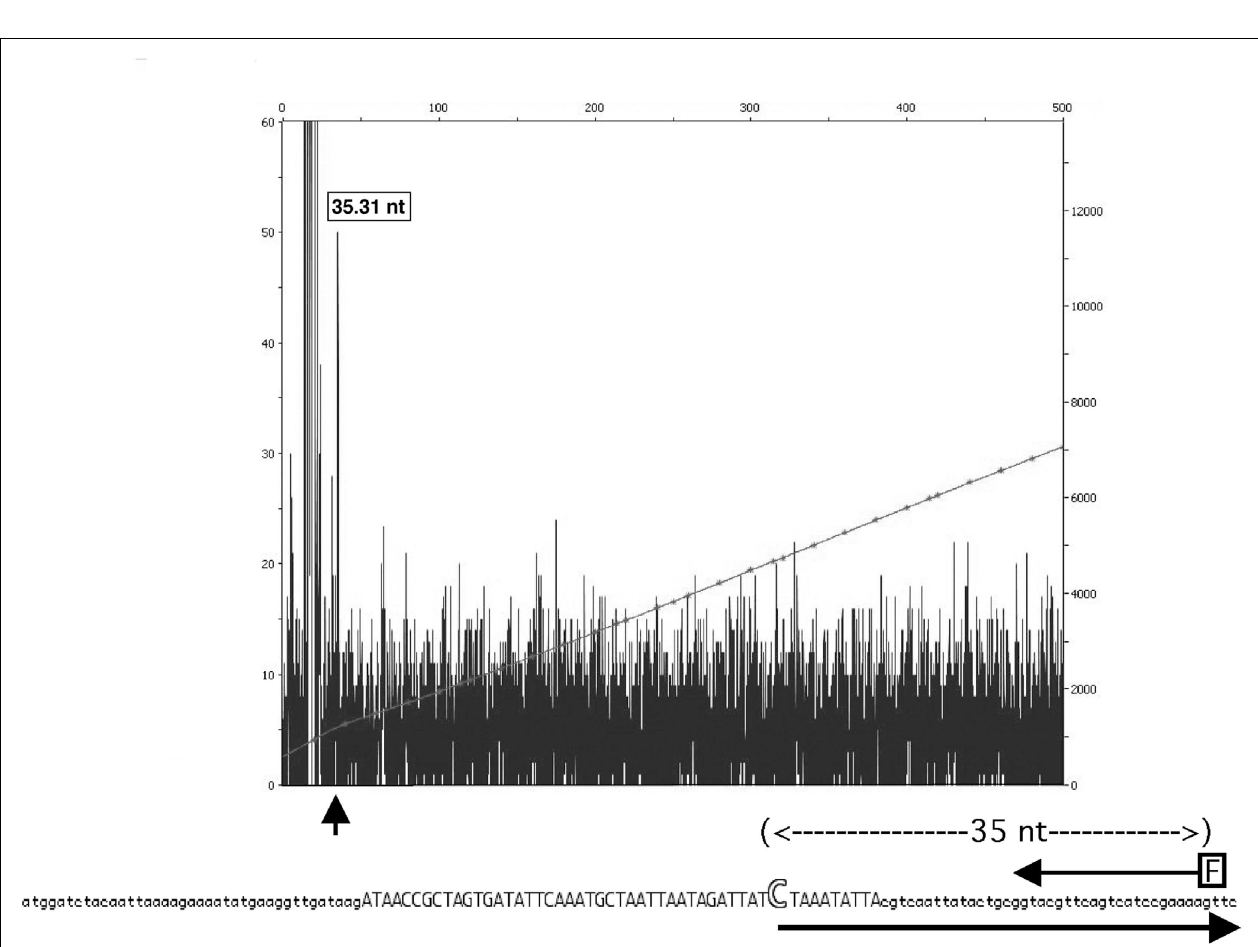
predicted mRNA.The encoded protein sequence of int is shown below for reference. No mRNA initiating from the region upstream of the integrase ORF could be detected.The X -axis of the figure corresponds to length of product in basepairs.The left Y -axis shows the relative fluorescence units of the sample peaks and right Y -axis shows the relative fluorescence units of the GeneScan 600 LIZ size standards.The small vertical arrow indicates the peak corresponding to the product of primer